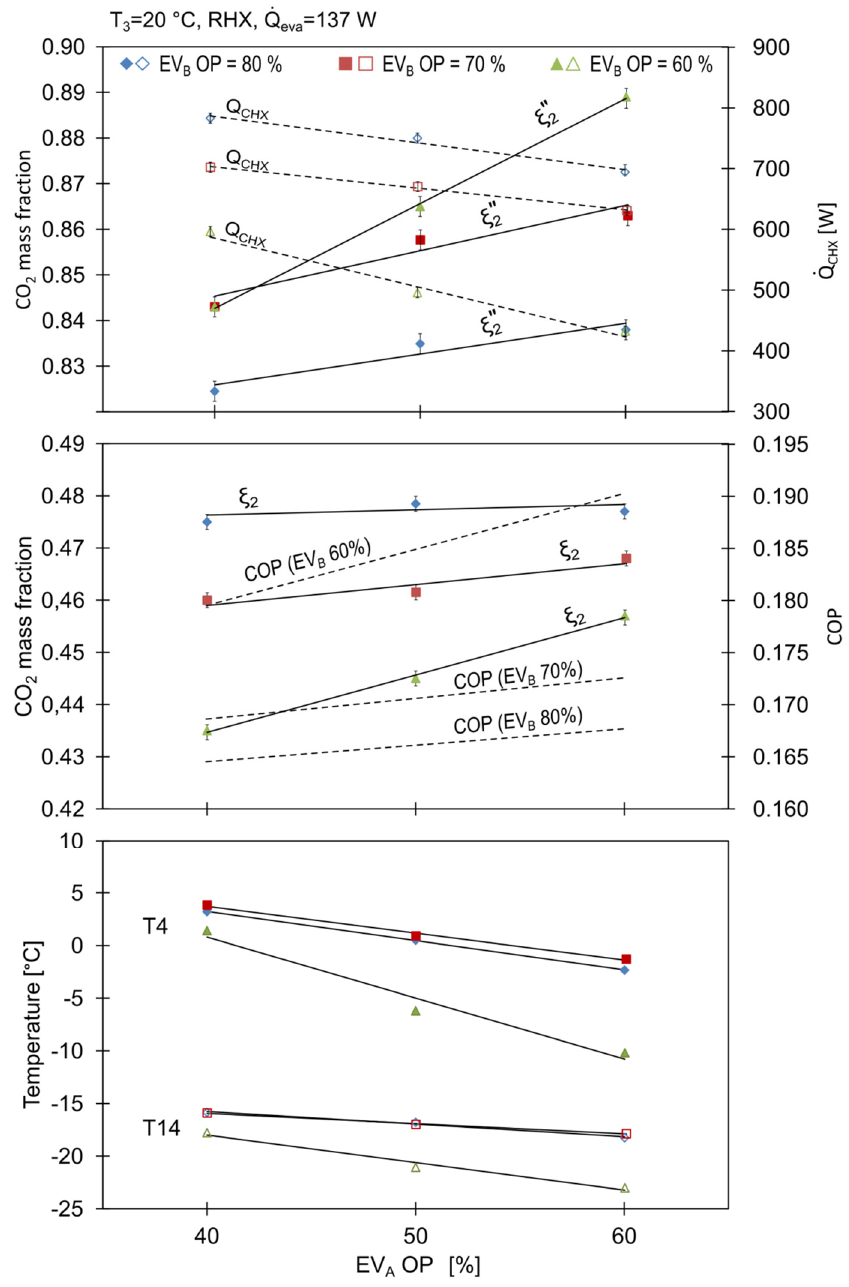
Figure 8. Influence of expansion valves openings on cycle characteristics.